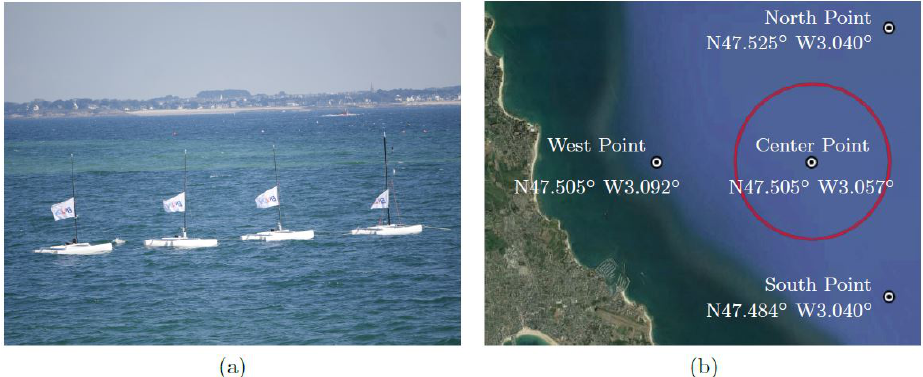
Figure 4. Fixed wind measurement points deployed. Picture ( a ) shows the 4 measurement platforms. Picture ( b ) shows position of the 4 measurement points during trials (white circle); the central one is always occupied by the platform fitted with the 3-anemometer mast (on the right in picture ( a )); the external locations are occupied by the others fitted with single-anemometer masts. The red circle shows the limit of the area of measurement (0.7 NM